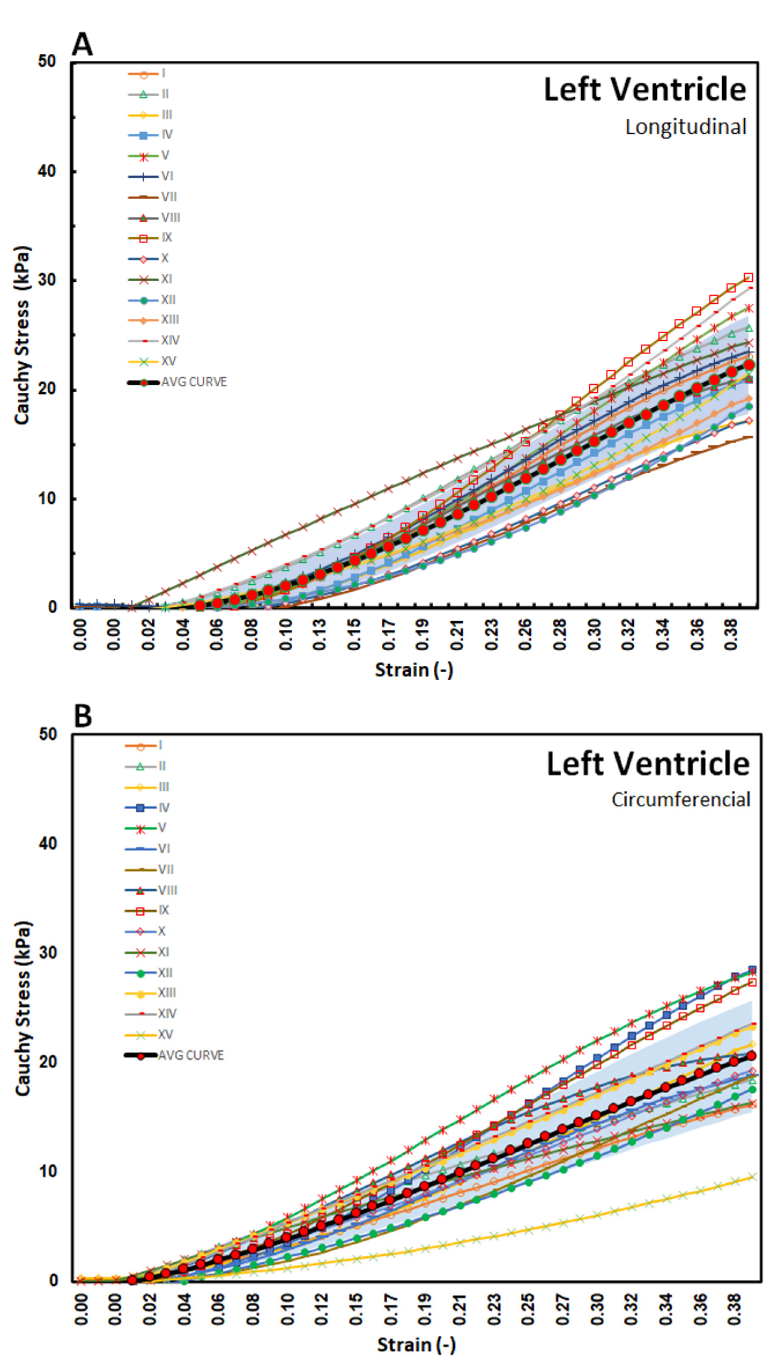
Figure 3. Stress–strain graphs for LV myocardium in the ( A ) longitudinal and ( B ) circumferential directions overlayed with one-standard deviation regions as well as an average curve.